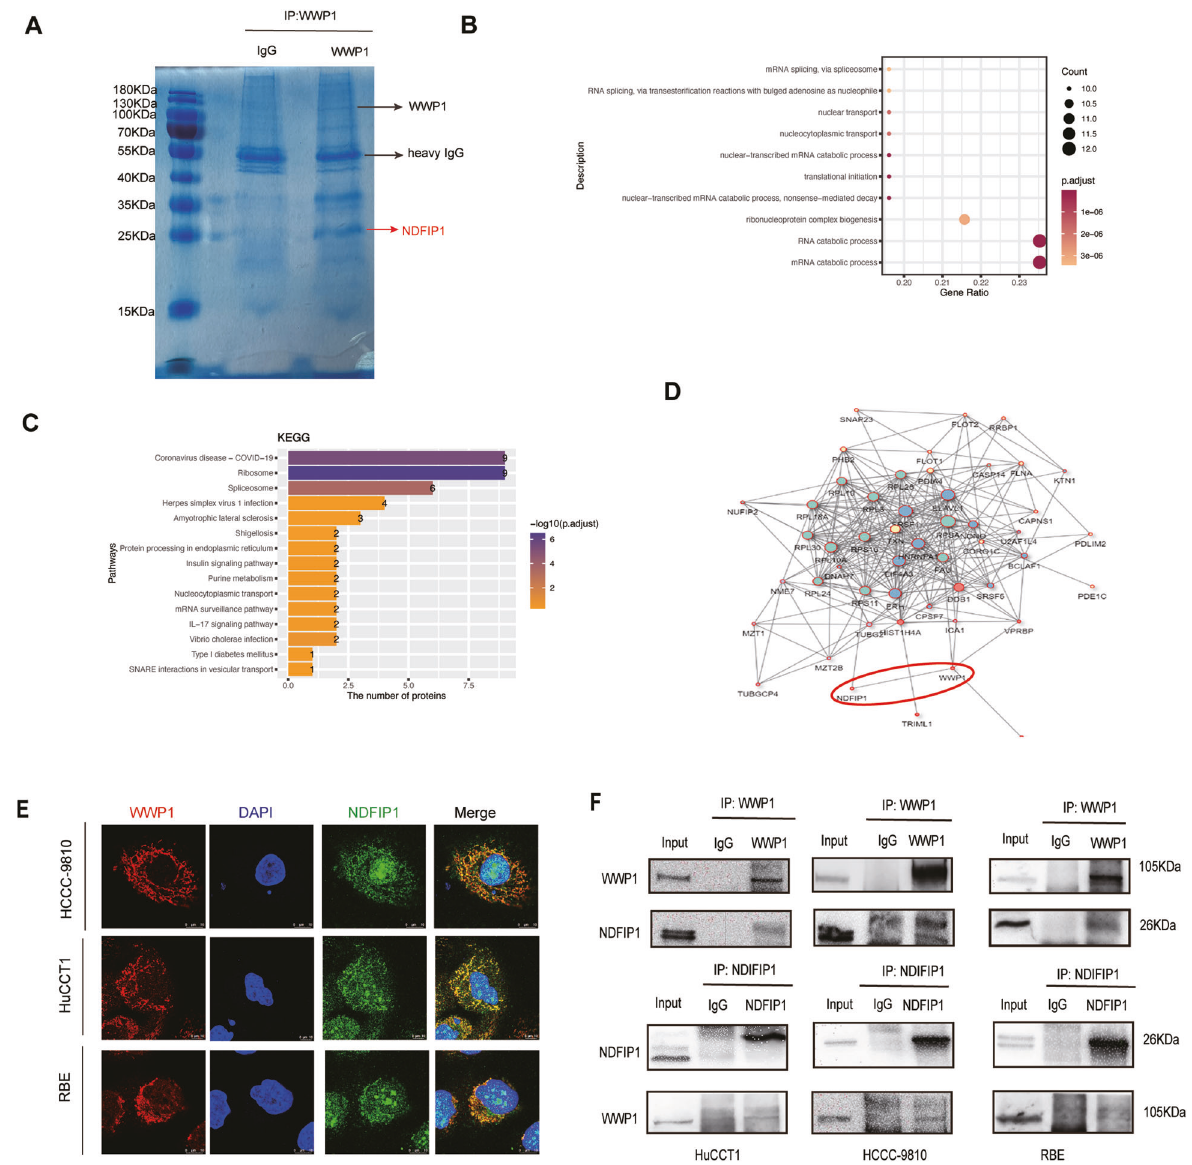
WWP1-binding proteins identi fi ed by mass spectrometry was performed. C WWP1 binding proteins were analyzed by KEGG pathway enrichment. D The protein-protein interaction network among proteins identi fi ed by mass spectrometry was constructed by PPI analysis in String Database. E WWP1(red) and NDFIP1 (green) colocalization in indicated cells was performed by confocal microscopy after immuno fl uorescence staining. F Interaction between WWP1 and NDFIP1 in HuCCT1, HCCC-9810, RBE cells were con fi rmed by co-IP assays followed by western